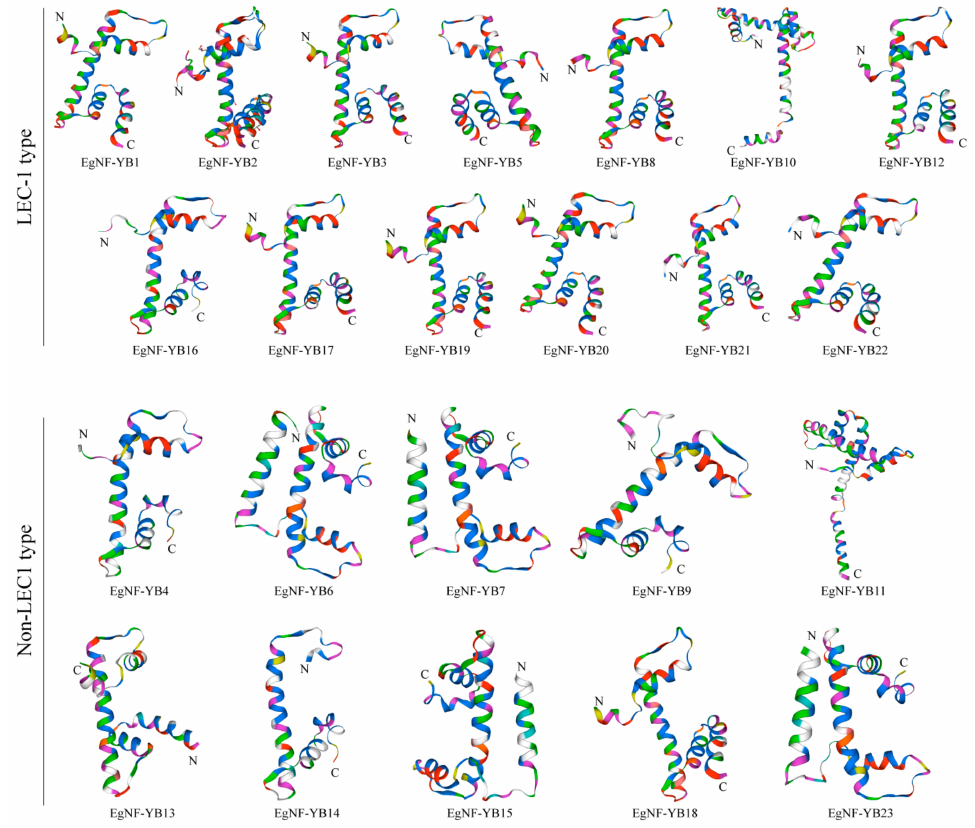
Figure 4. Homology modeling of NF-YB protein in Eucalyptus grandis . The 3D structure of NF-YB protein was predicted based on the Swiss-model